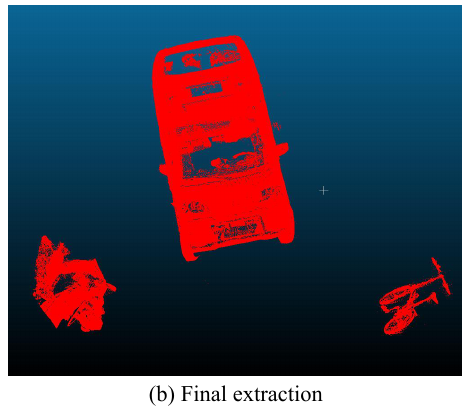
Figure 6. Automatic extraction effect of accident vehicle point cloud